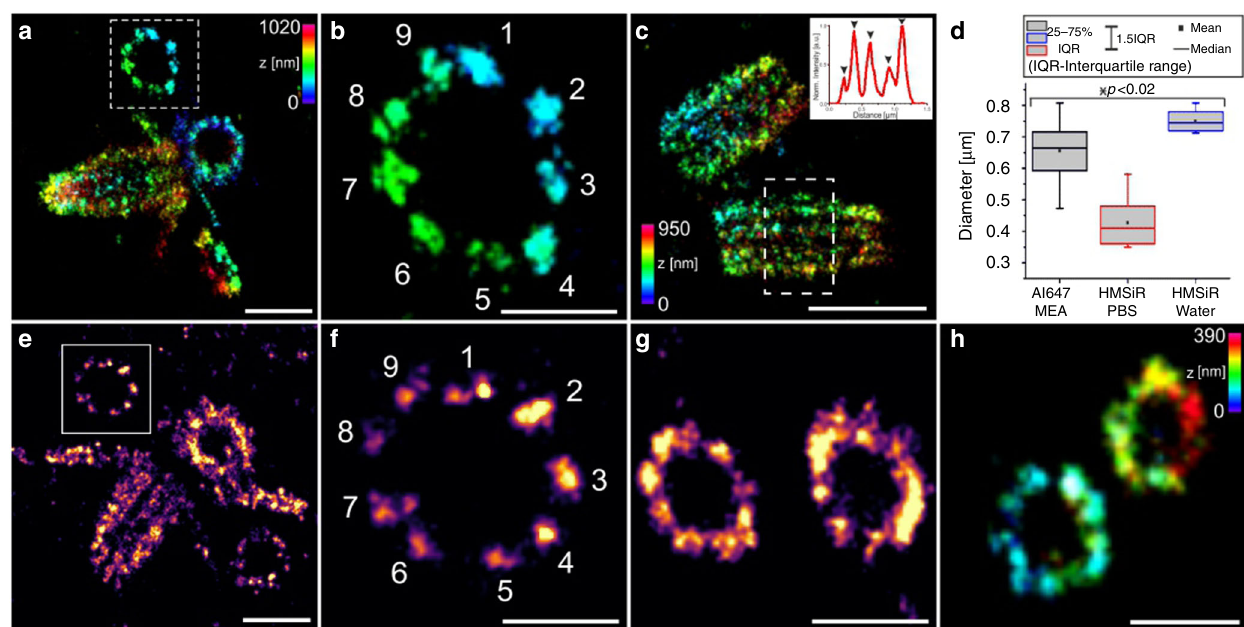
Fig. 4 Ex-SMLM of U-ExM expanded centrioles. a - c 3D d STORM image of U-ExM expanded and re-embedded Chlamydomonas centrioles stained post re- embedding with anti α -tubulin primary antibody and Alexa Fluor 647 conjugated secondary antibodies measured in MEA buffer. b Zoom-in on highlighted region in ( a ) revealing the 9-fold symmetry of the shown procentriole. c Side view of two mature centrioles with clearly separated triplets. The inlet shows the cross-sectional pro fi le along the centriole (white box) showing fi ve distinct peaks of microtubule triples (marked with arrow heads). d Comparison of the diameters determined from expanded centrioles measured using different protocols (re-embedded and labeled with Alexa Fluor 647, and imaged in MEA photoswitching buffer, labeled with HMSiR 647 and imaged in double-deionized water or in pH optimized PBS (1x) buffer with pH 7.4). Mean values are 657 ± 90 nm (mean ± sd) for Alexa Fluor 647 in MEA buffer ( n = 12 centrioles), 428 ± 74 nm (mean ± sd) for HMSiR in PBS ( n = 7 centrioles), and 750 ± 34 nm (mean ± sd) for HMSiR 647 in water ( n = 8 centrioles). Data from n = 2 independent experiments for each condition. Divided by the previously analyzed diameter of α -tubulin labeled centriole expansion factors translates into ~3.4x, ~2.2x, and ~3.9x for expanded centrioles labeled with Alexa Fluor 647 in MEA buffer, HMSiR in PBS (1x), and HMSiR 647 in water, respectively. Statistical signi fi cance was assessed by one-way ANOVA: the mean values of the diameters are signi fi cantly different with p <0.02 ( F = 3.80) (* P ≤ 0.05, ** P ≤ 0.01). e – g 2D d STORM image of U-ExM expanded centrioles labeled with HMSiR 647 imaged in water ( e – f ) or PBS(1x) ( g ) f Zoom-in on highlighted region in ( e ). h 3D d STORM image of unexpanded isolated Chlamydomonas centrioles immunostained with antibodies against glutamylated tubulin and Alexa Fluor 647 conjugated secondary antibodies. Scale bars, 1 µ m ( a , e